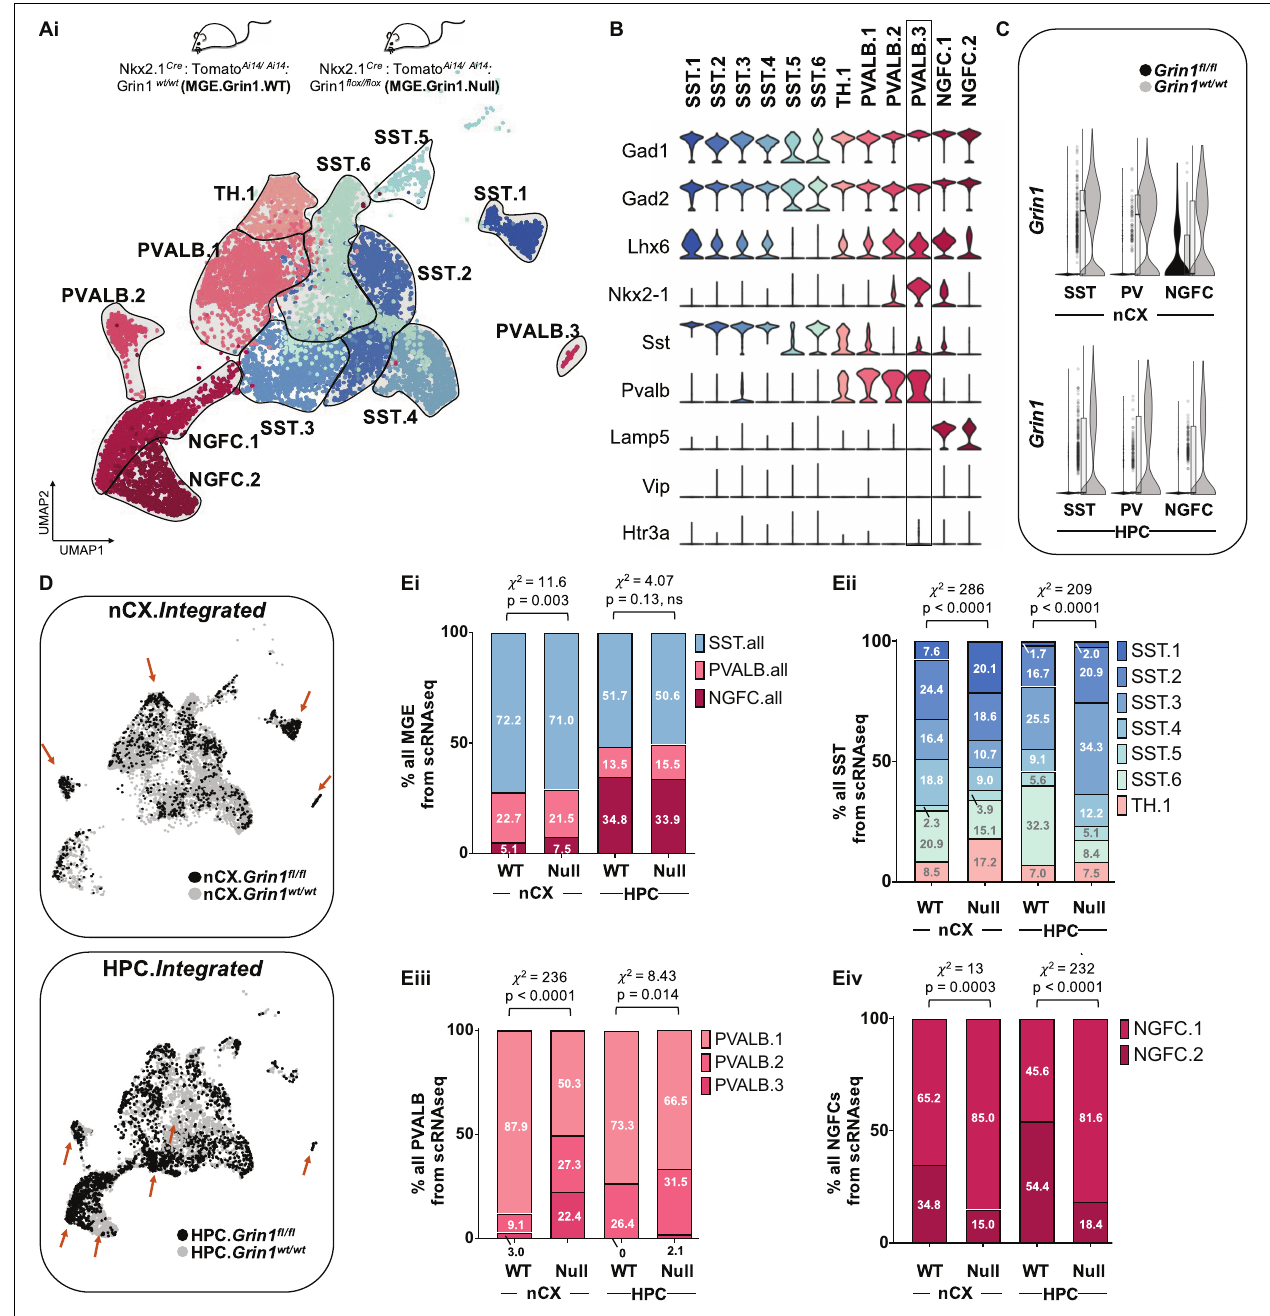
FIGURE 2 | Altered interneuron subtype proportions upon Grin1 -ablation. (A) Integrated UMAP visualization of 12 subtypes of MGE-derived interneurons obtained from neocortex (nCX) and hippocampus (HPC) of Grin1 wt / wt and Grin1 fl / fl mice. UMAP represents the following numbers of MGE-derived interneurons from Grin1 wt / wt and Grin1 fl / fl , respectively: 5624 (nCX.WT) and 1387 (nCX.NULL); 2998 (HPC.WT) and 2309 (HPC.NULL). 3 and 2 independent biological replicates of the scRNAseq assay from Grin1 wt / wt and Grin1 fl / fl , respectively. (B) Violin plot showing the distribution of expression levels of well-known representative cell-type-enriched marker genes across the 12 interneuron subtypes. (C) Violin plot from both genotypes indicating the expression of Grin1 in the cardinal of MGE-derived interneuron subtypes. (D) UMAP representation colored by brain-region, highlighting the differential enrichments of cells (brown arrows) within interneuron subsets in Grin1 wt / wt and Grin1 fl / fl from nCX and HPC. (E) Stacked-barplots representing the proportions of recovered cell numbers within (Ei) , pooled cardinal MGE subtypes, (Eii) , SST subtypes; (Eiii) , PVALB subtypes, and (Eiv) , NGFC subtypes in Grin1 -WT and Grin1 -null from neocortex or hippocampus. x 2 , Chi-square test of proportions; ns, not